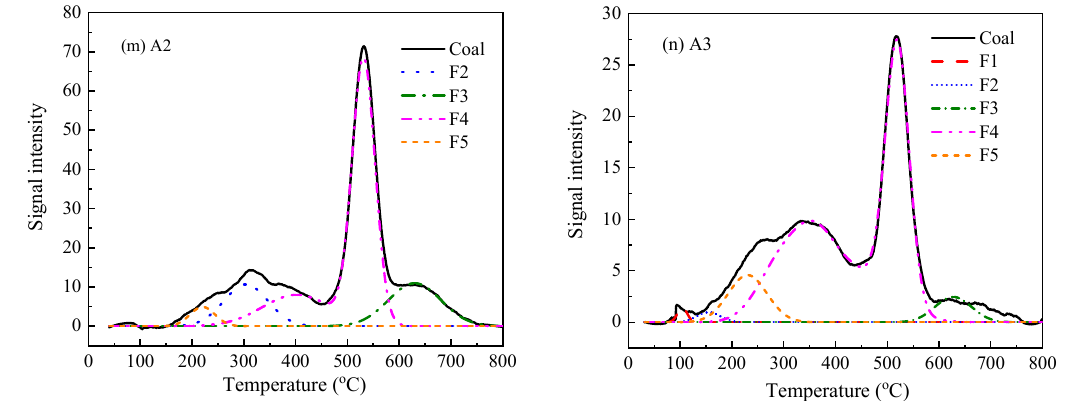
Figure 7. The thermogram for five Hg fractions in coals. ( a ) P1. ( b ) P2. ( c ) L1. ( d ) L2. ( e ) L3. ( f ) SB1. ( g ) SB2. ( h ) SB3. ( i ) B1. ( j ) B2. ( k ) B3. ( l ) A1. ( m ) A2. ( n )